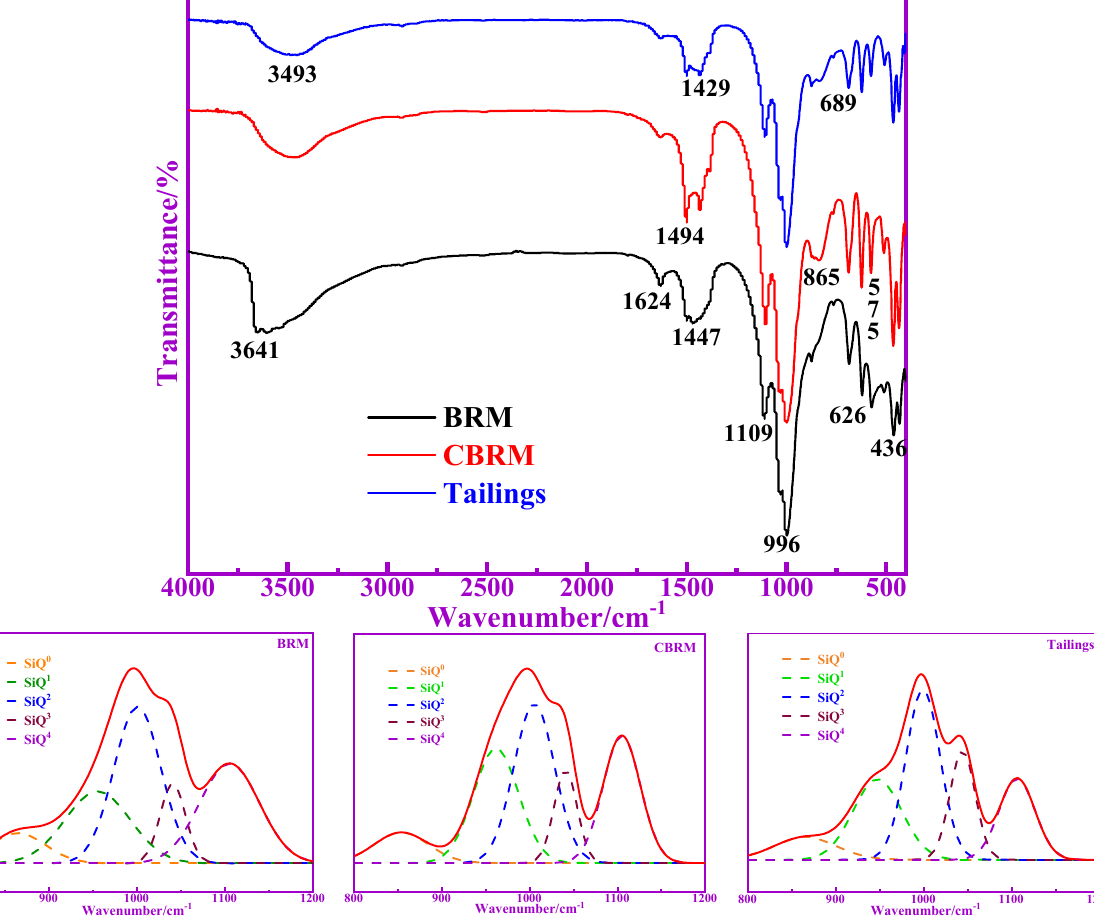
Figure 7. FTIR spectra of BRM, CBRM, and Tailings.